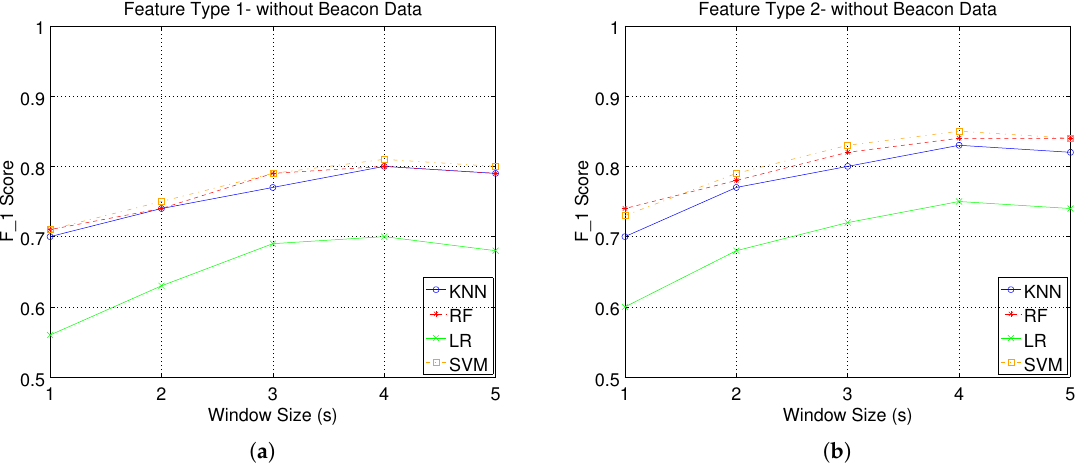
Figure 7. Activity recognition system performance without beacon data: weighted average of F 1 score over all activities, for different window sizes, feature types and classification models. ( a ) Wearable Feature Type 1 (mean, standard deviation); ( b ) Wearable Feature Type 2 (mean, standard deviation, mean crossing rate, maximum and minimum).